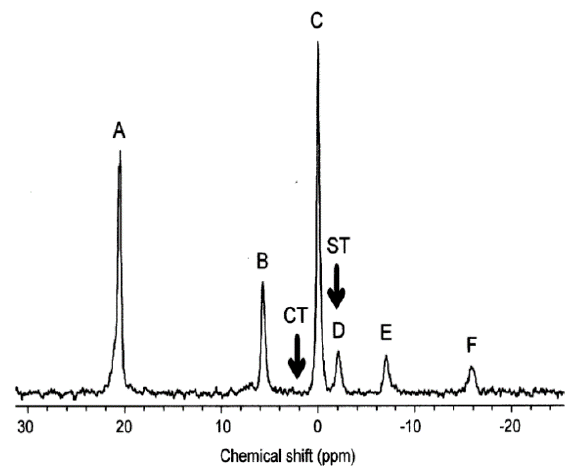
Figure 1. An example of an early NMR exposure study. The 31 P NMR spectrum of molluscs (mussels) during acute exposure to copper. The assigned peaks are: A, MDP external standard; B, inorganic phosphate; C, phosphoarginine; D, overlapping γ -ATP and β -ADP; E, overlapping α -ATP, α -ADP and NADH; and F, β -ATP [118]. Modified with permission from Elsevier.